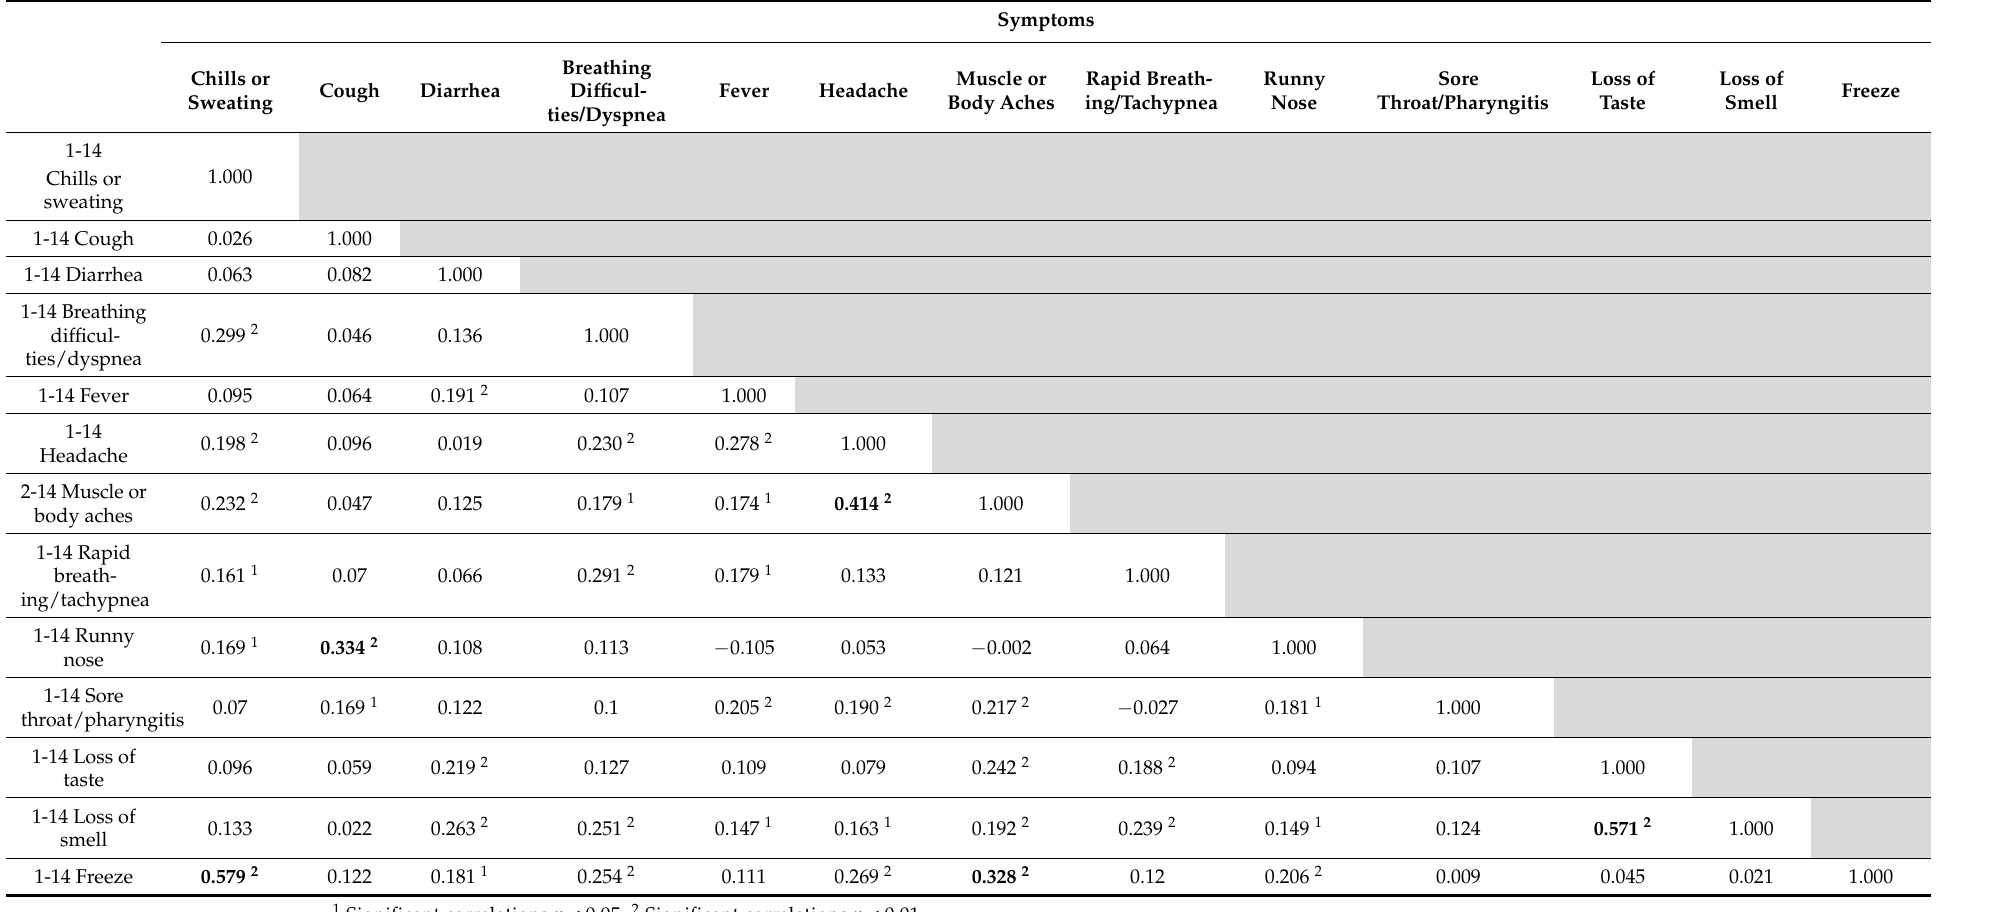
Symptoms Muscle or Rapid Breath- Body Aches ing/Tachypnea